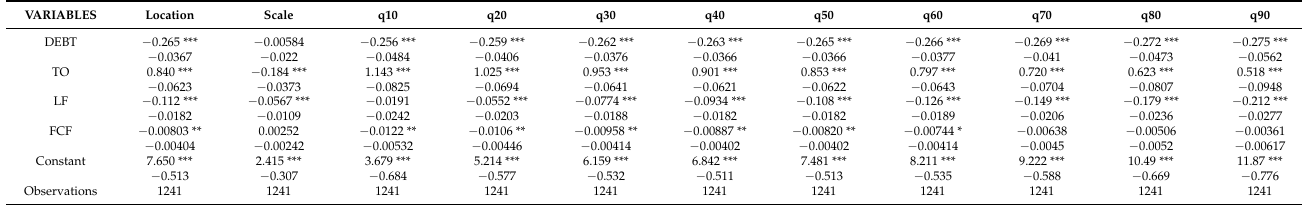
Table 3. Impact of public debt on economic growth.